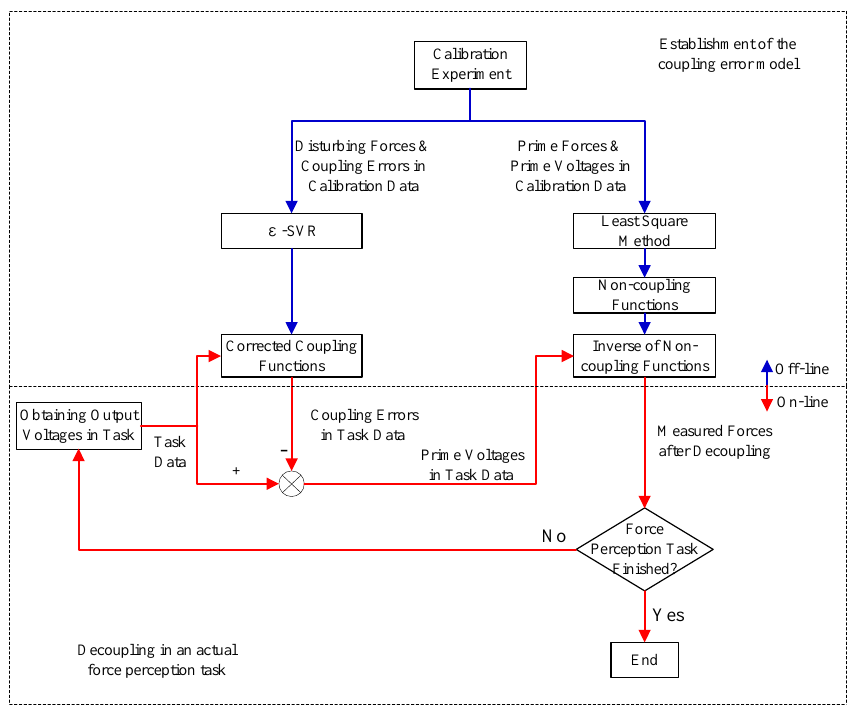
Figure 3. The flow chart of the whole decoupling